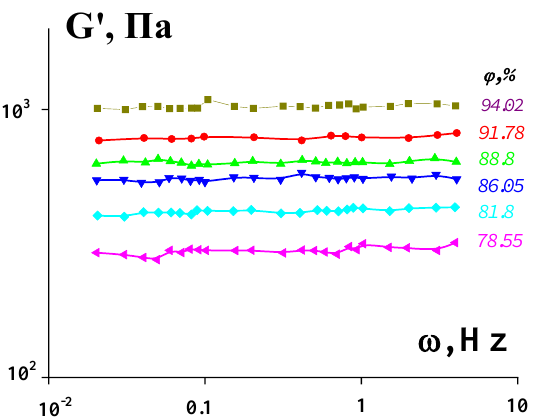
Figure 12. Frequency dependences of the elastic modulus of highly concentrated emulsions below the yield stress, (according to the experimental data presented in [63]). Concentrations are shown at the curves.